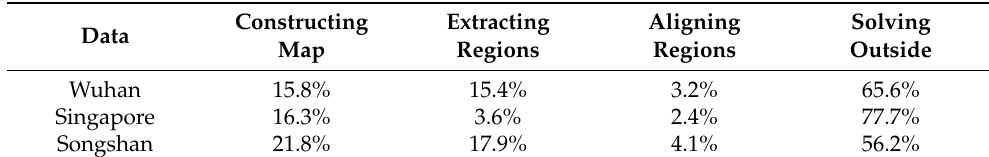
Table 4. Runtime (%) of four steps in the proposed method.